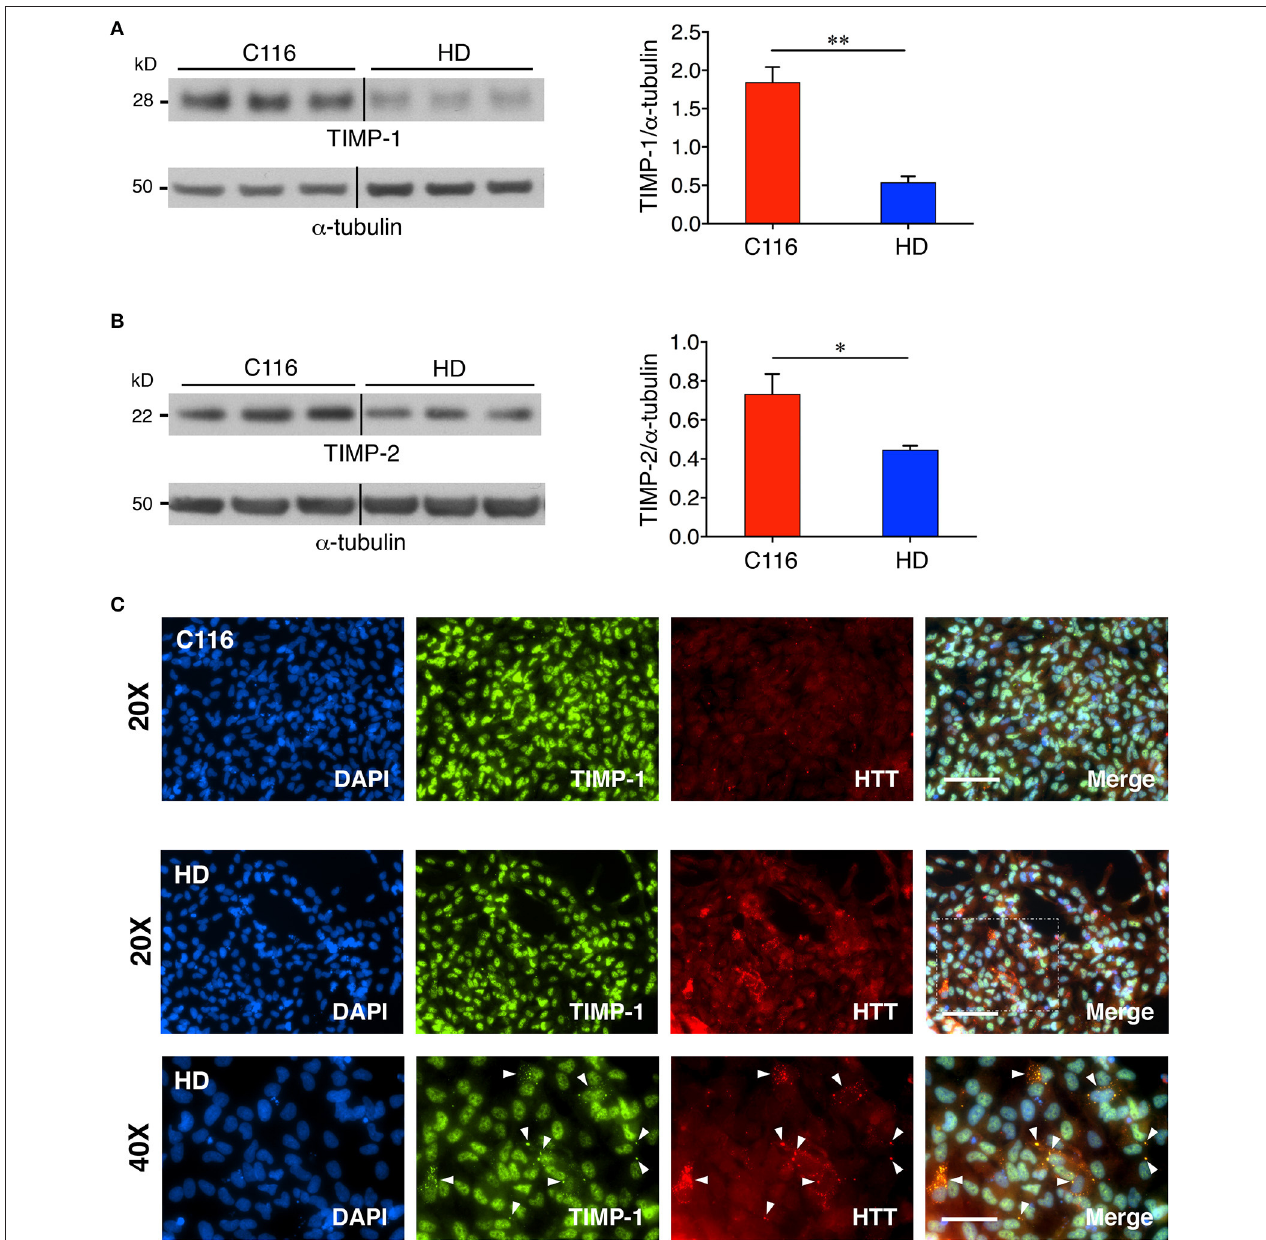
FIGURE 5 | TIMP expression is downregulated in HD-NSCs. Western blot analysis of TIMP-1 (A) and TIMP-2 (B) expression reveals significantly decreased levels in HD-NSCs compared to C116-NSCs ( n = 3 BR, * p < 0.05; ** p < 0.01; t -test). Error bars represent SD . Immunofluorescence analysis using anti- TIMP-1 antibody (C) demonstrates nuclear localization of TIMP-1 and suggests a direct association between TIMP-1 and mHTT aggregates in HD-NSCs (40X magnified inset, white arrowheads). Scale Bars: 20X = 100 µ m, 40X = 50 µ